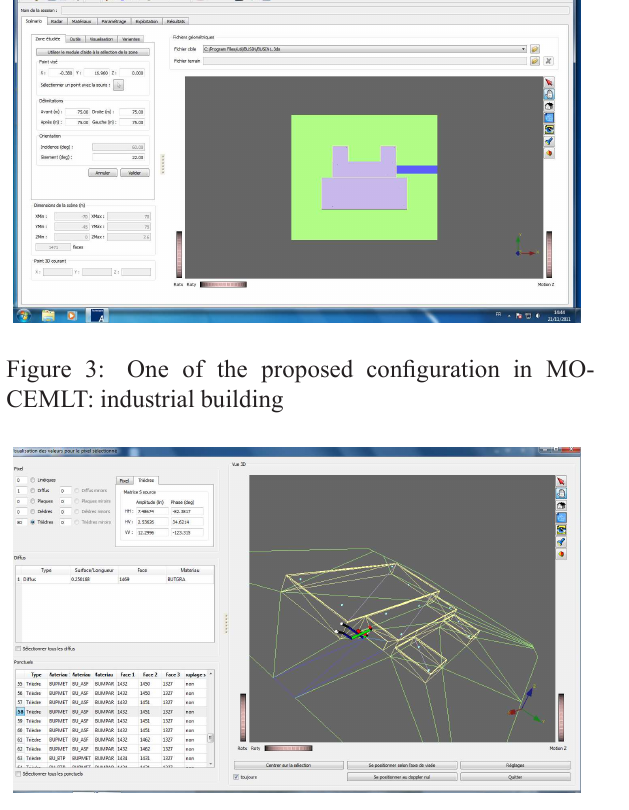
Figure 4: 3D view of the main mechanisms